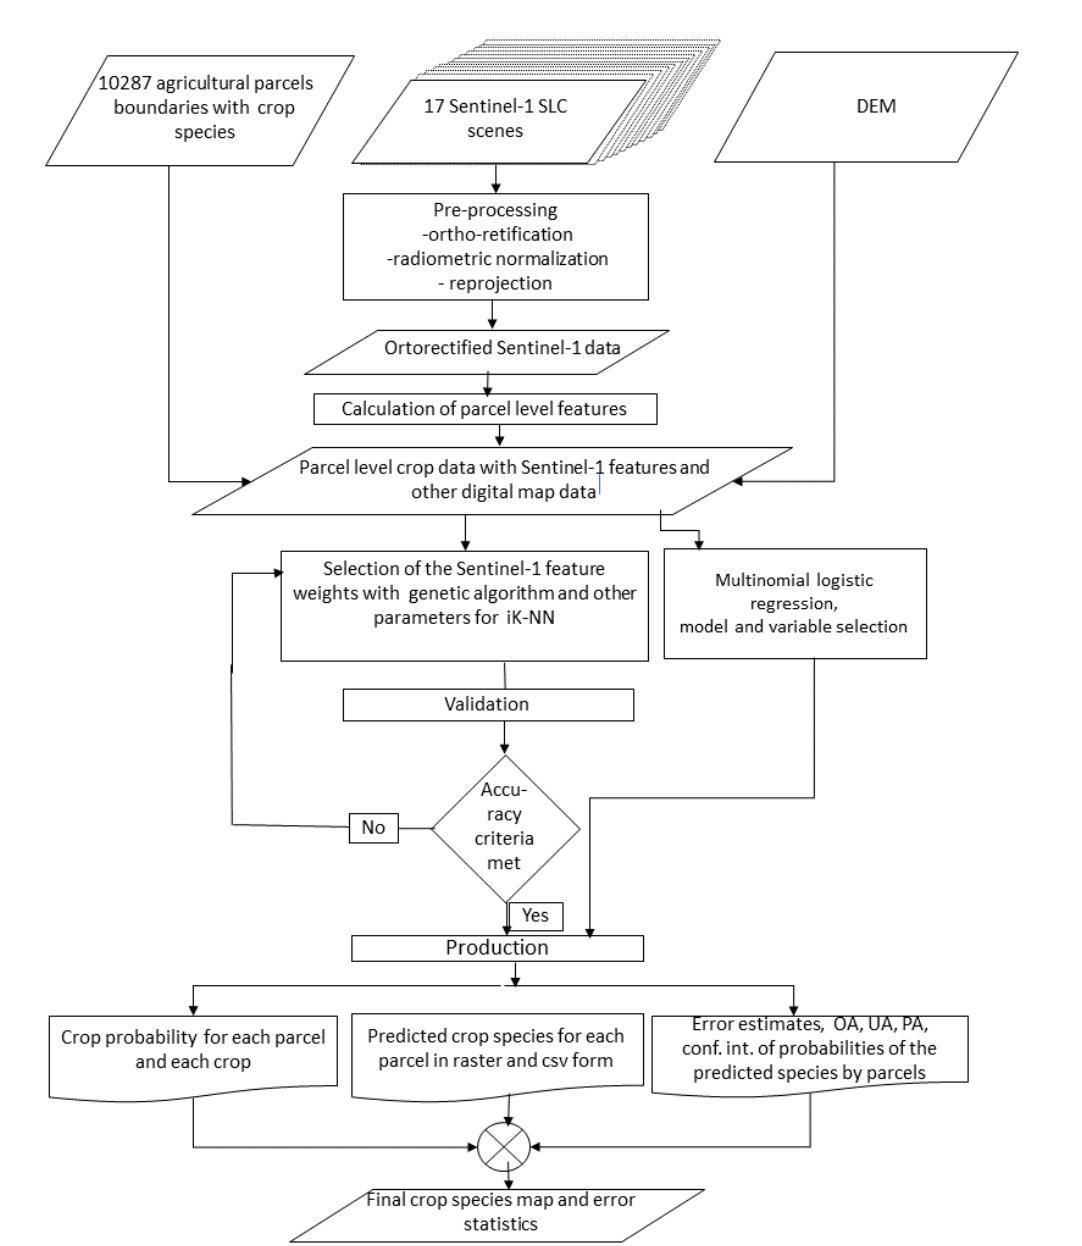
Figure 3. The flowchart of the